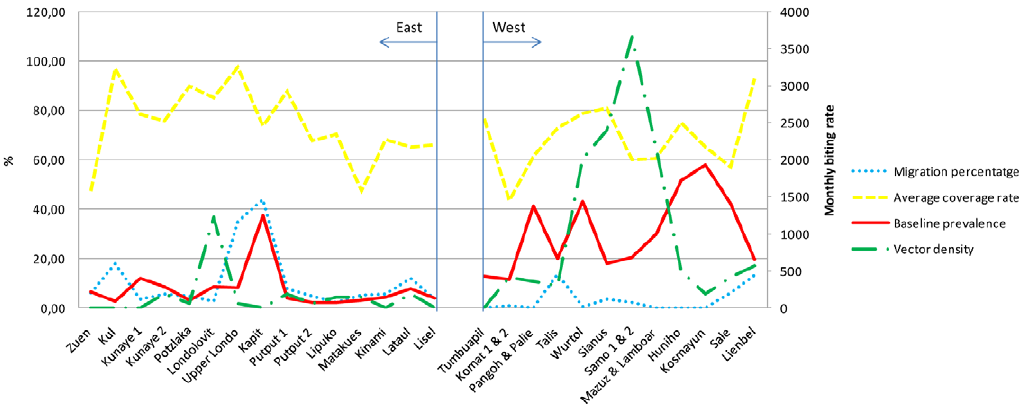
Figure 1. Baseline epidemiological, infection status and entomological data and program coverage details of 27 villages, Lihir Island.